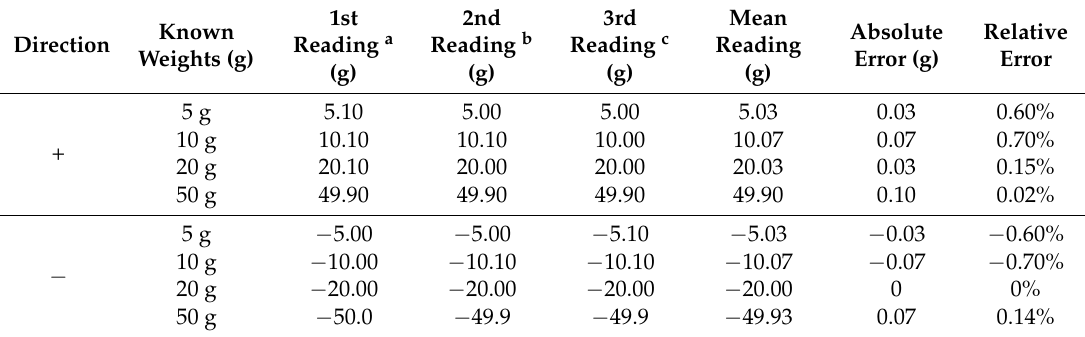
Table 1. Comparison between known weights and force sensor